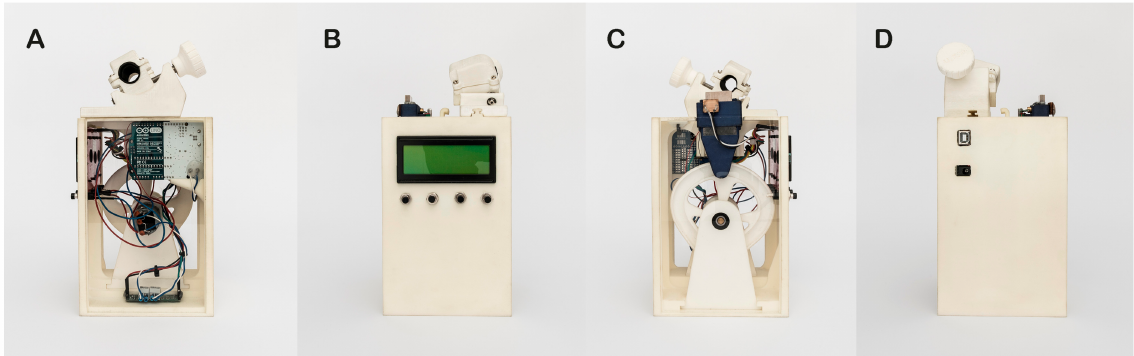
Figure 3. ( A ) Front, ( B ) back, and ( C , D ) lateral surfaces of the dynamic cyclic fatigue hardware